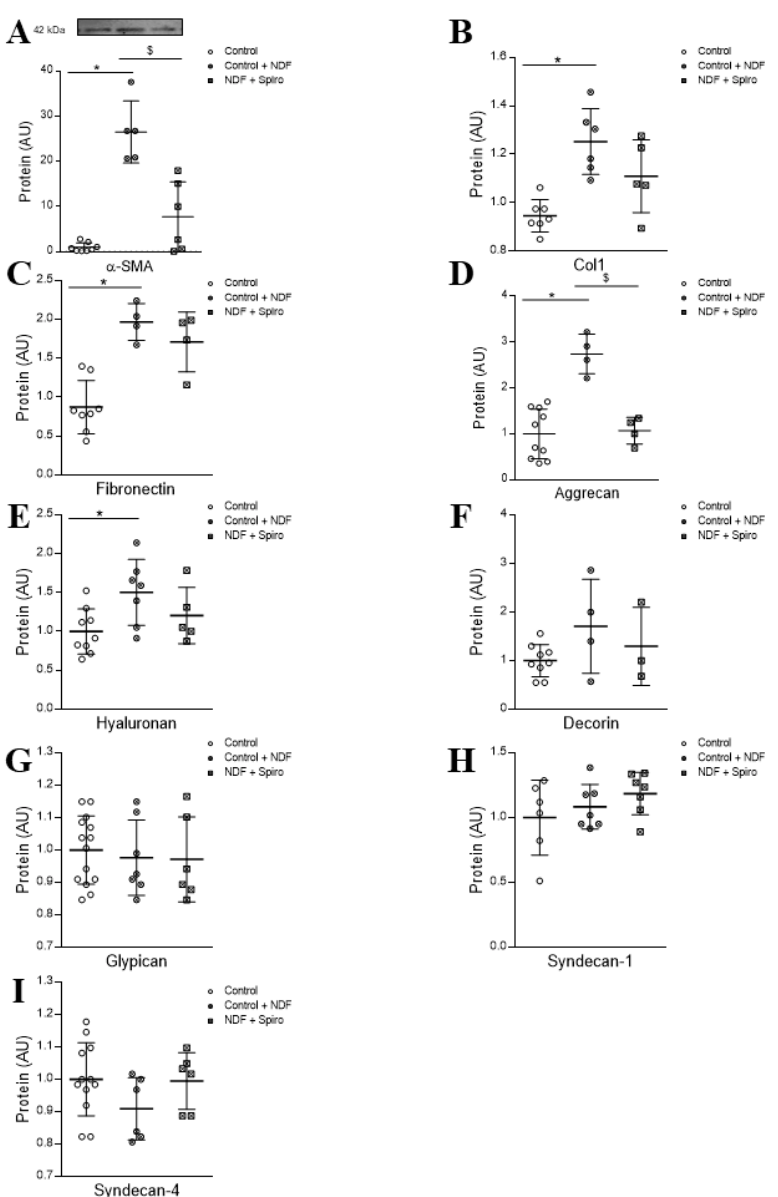
Figure 4. NDF induces the expression of activation and fibrosis markers in adult human cardiac fibroblast. NDF effects on the activation marker α -SMA protein expression in adult human cardiac fibroblasts (* p = 1.0 × 10 − 7 ; $ p = 1.6 × 10 − 5 Control + NDF vs. NDF + Spiro) ( A ). Quantification of collagen type I (* p = 0.0410; $ p = 0.0208 ( B ) and the non-fibrillar protein fibronectin (* p = 0.0172)) ( C ) in human cardiac fibroblasts treated with NDF and NDF + Spiro. Quantification of proteoglycans (aggrecan (* p = 6 × 10 − 6 ; $ p = 1.25 × 10 − 4 Control + NDF vs. NDF + Spiro) ( D ), hyaluronan ( E ), decorin ( F ), glypican ( G ), syndecan-1 ( H ) and syndecan-4 ( I ) in human cardiac fibroblasts treated with NDF and NDF + Spiro. The box plots show the individual datapoints and the horizontal bars indicate the mean and SEM in arbitrary units versus the control group. The results were analyzed using one-way ANOVA, followed by Tukey’s multiple comparisons tests. * vs. control, $ vs. control +